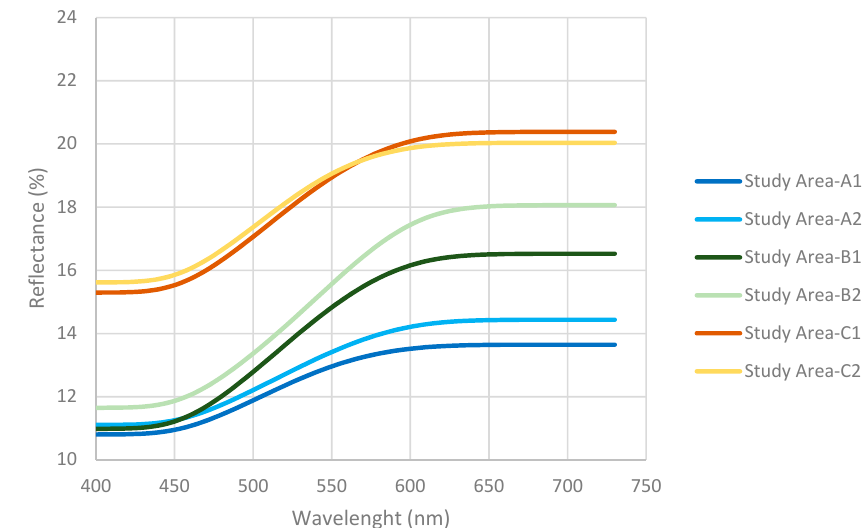
Figure 9. Spectral data of colorimeter (after conversion) for areas A1–C2.